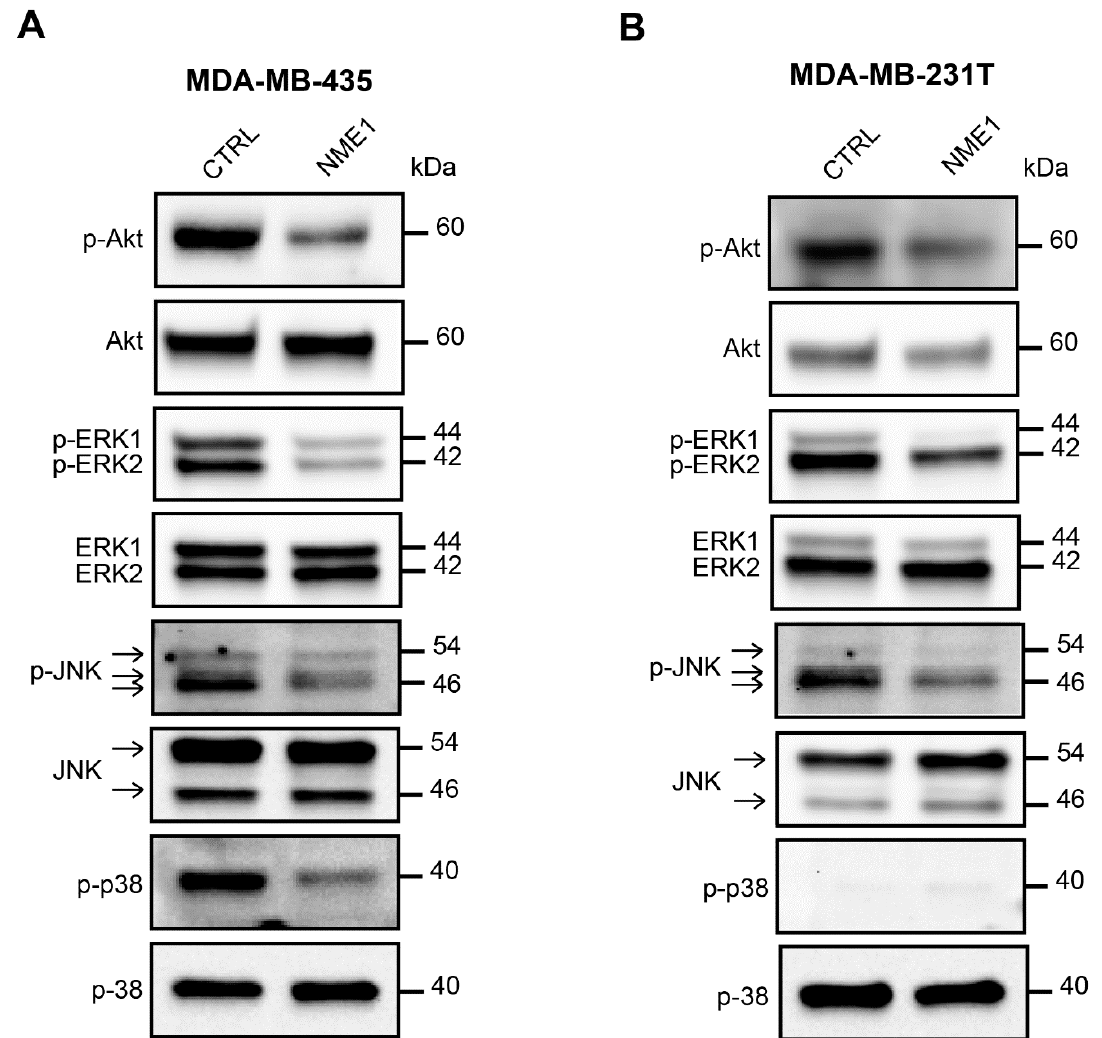
Figure 8. Overexpression of NME1 inhibits the activity of pro-EMT signaling pathways. ( A ) Lysates of MDA-MB-435 human breast carcinoma cells stably transfected with the empty control vector (CTRL) or with a vector expressing NME1 (NME1) were analyzed by Western blotting with antibodies against the phosphorylated forms of Akt, and ERK1/2, JNK and p38, as in Figure 7. Molecular weights are indicated in kDa. ( B ) Lysates of MDA-MB-231T human breast carcinoma cells, as in part ( A ).